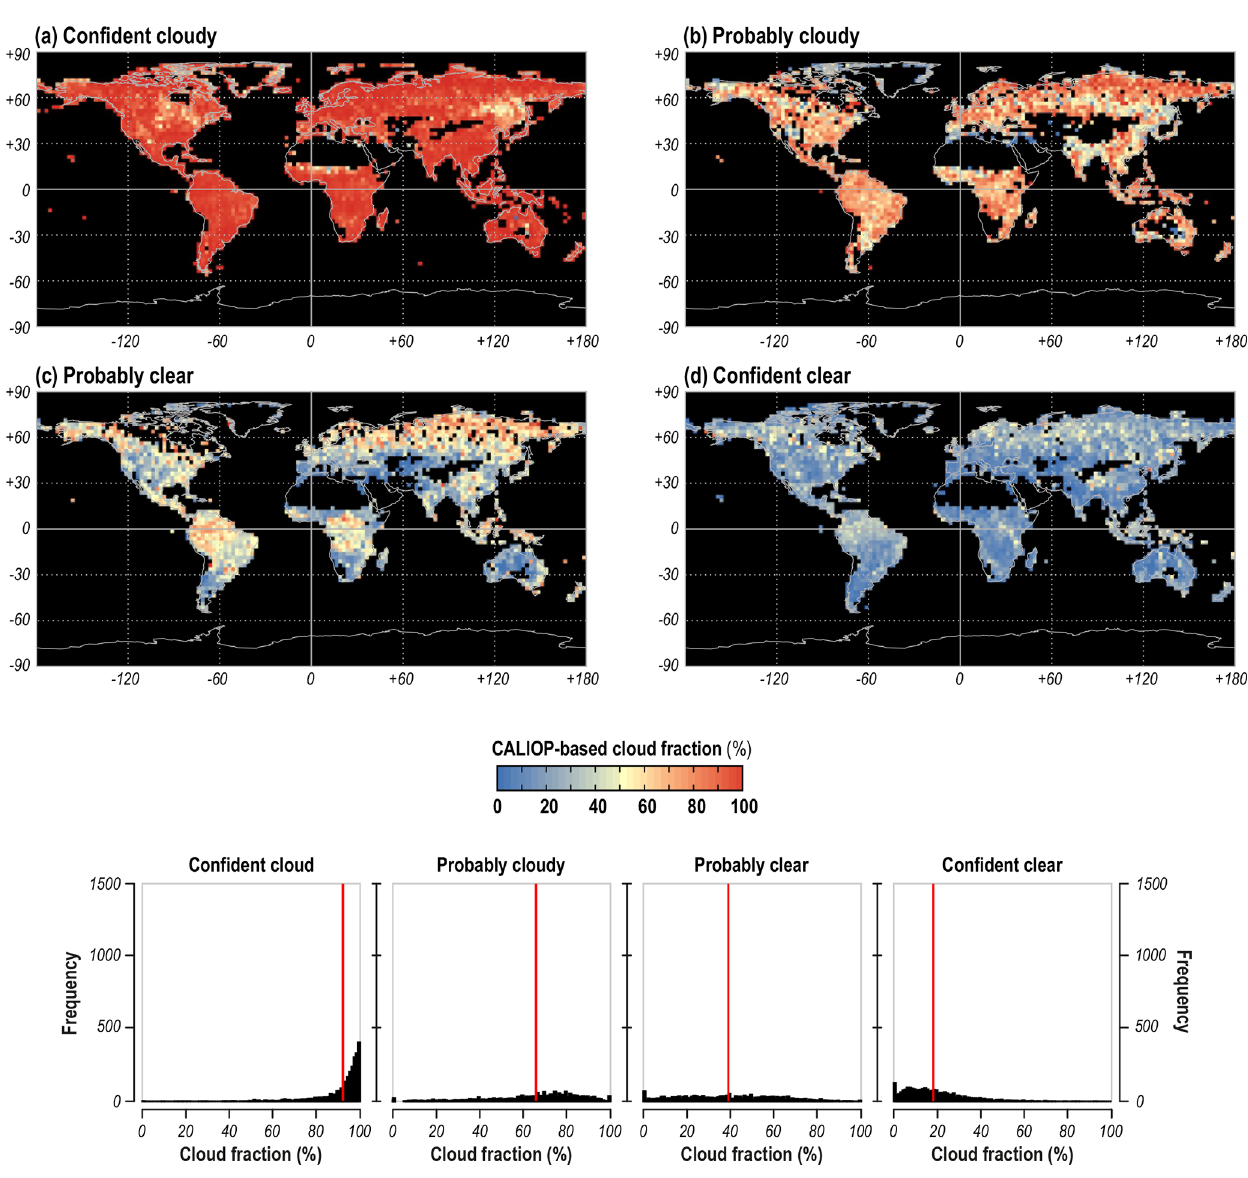
Figure 6. CALIOP-based cloud fraction for MODIS cloud mask classes for the “daytime, snow-free land” algorithm path and corresponding histograms (red vertical line indicates the mean